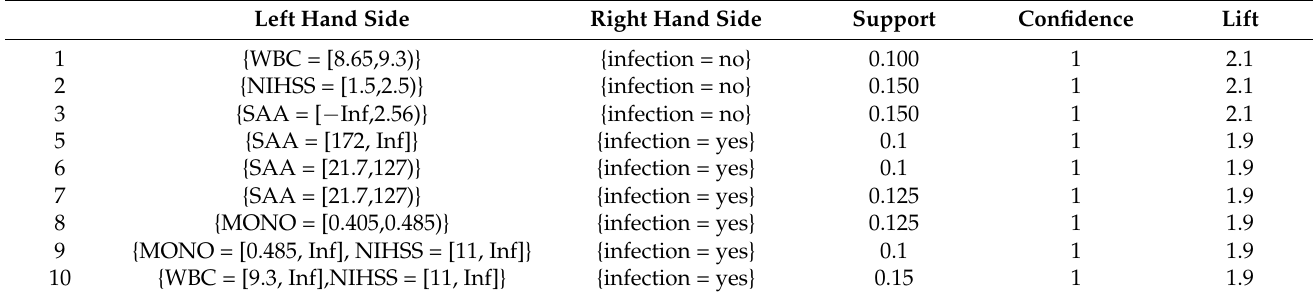
Table 4. Classification and association rules in the discovery subgroup.